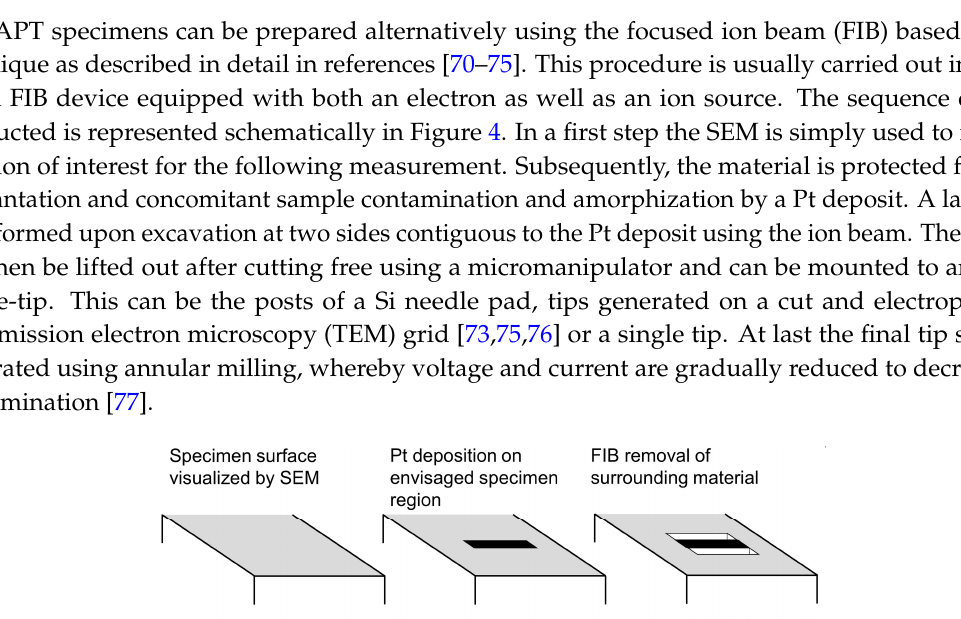
Figure 4. Scheme of the atom probe tomography (APT) specimen preparation by lift-out technique.